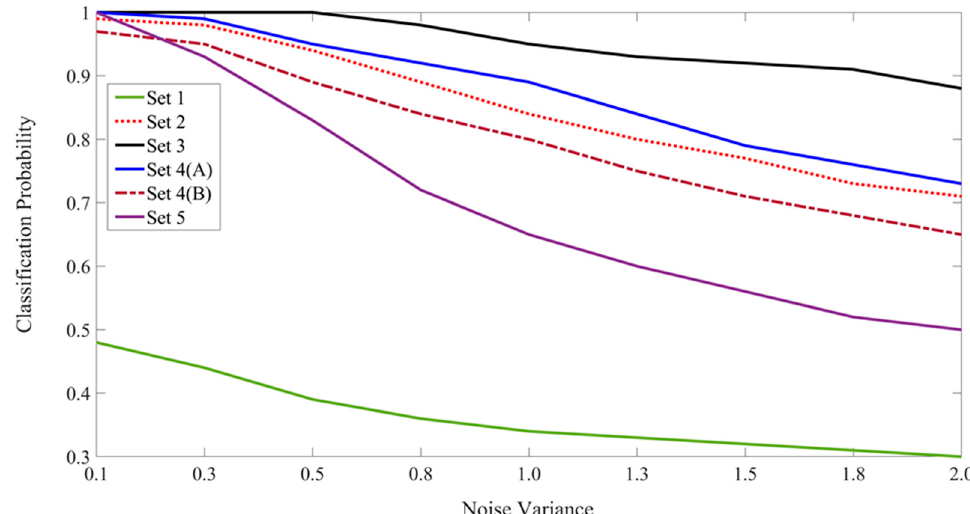
Figure 14. The plot of the classification probabilities for the six sets of experiments involving the classification of ambiguous letters.